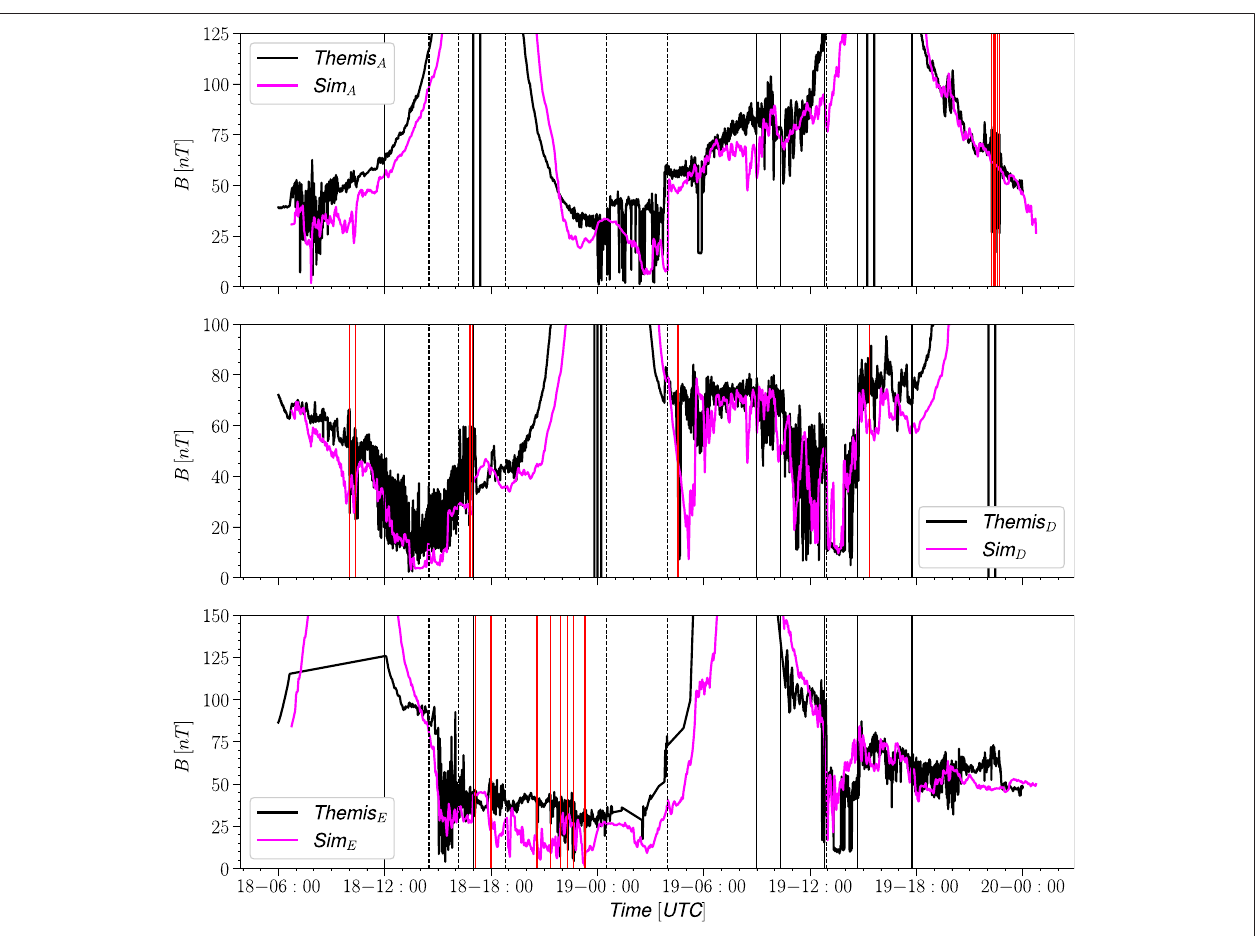
FIGURE 5 | Magnetic fi eld magnitude trace observation vs simulation Themis A, D, and E. Vertical red lines indicate crossings as determined by Staples et al. (2020).